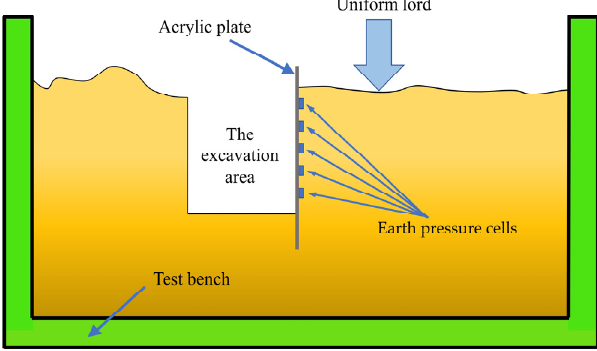
Figure 9. Layout of earth pressure cells and model plate.